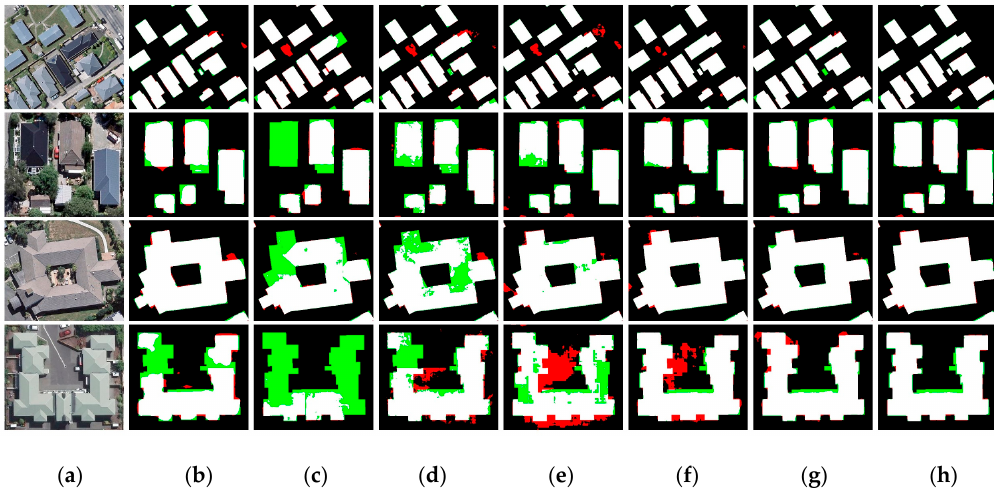
Figure 6. Visual comparison of segmentation results by seven approaches. In the colored images, the white, red and green colors represent true positive, false positive and false negative predictions, respectively. ( a ) Image. ( b ) FCN-8s. ( c ) SegNet. ( d ) DeconvNet. ( e ) U-Net. ( f ) ResUNet. ( g ) DeepUNet. ( h ) DeepResUnet.